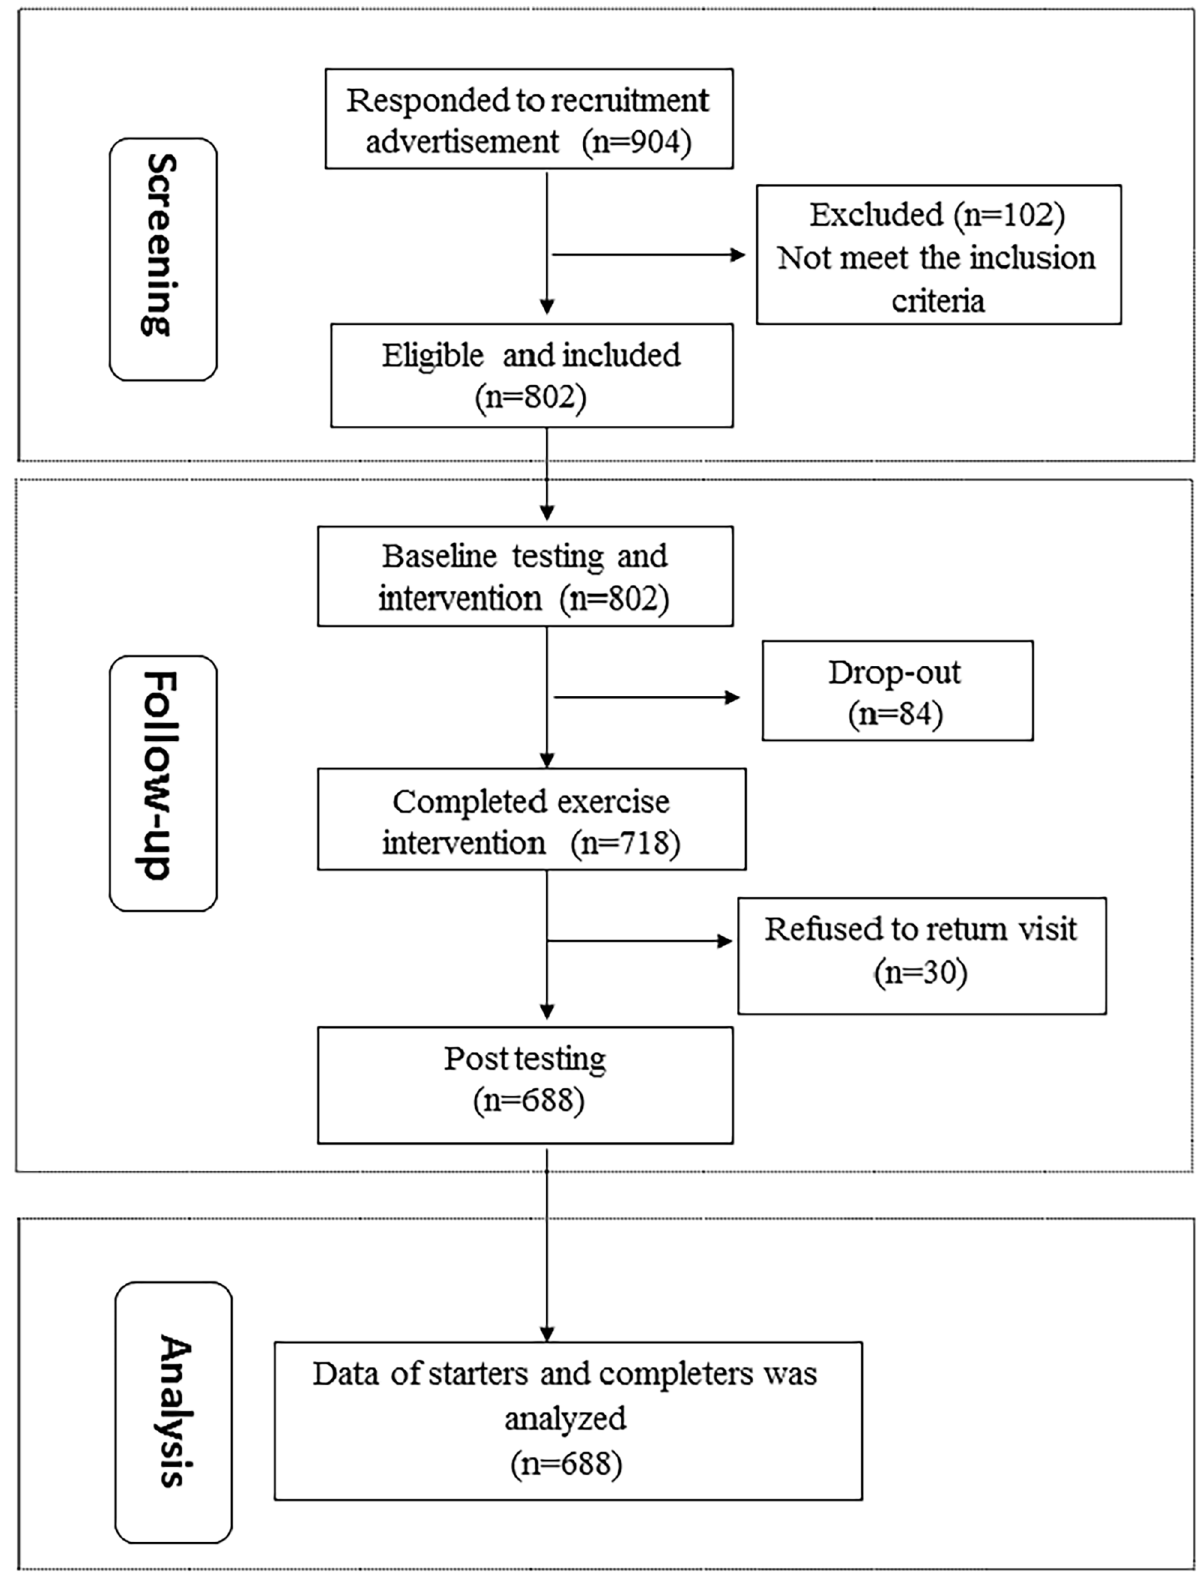
Fig 1. The changes in outcome measures after 3-month walking intervention for different BMI populations. https://doi.org/10.1371/journal.pone.0190848.g001 PLOS ONE | https://doi.org/10.1371/journal.pone.0190848 January 11,